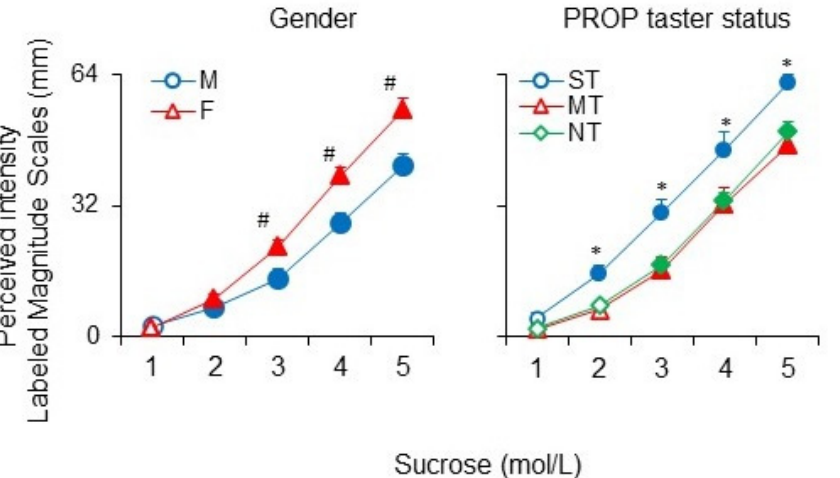
Figure 2. Mean values ± SEM of the perceived intensity ratings after stimulation with the five sucrose suprathreshold solutions according to gender and PROP Taster status. The numbers 1, 2, 3, 4, 5 on the X -axis correspond to 0.01, 0.032, 0.1, 0.32, and 1 mol/L concentration, respectively. n = 107. The solid symbol denotes a significant difference from the previous value ( p ≤ 0.037; Fisher LDS, after repeated-measures ANOVA). # indicates a significant difference between the corresponding values of females and of males ( p ≤ 0.0076; Duncan’s test, after repeated-measures ANOVA) * Indicate significant differences between the value of super tasters (ST) and the corresponding values of medium tasters (MT) and non-tasters (NT) ( p ≤ 0.043; Fisher LDS, after repeated-measures ANOVA).